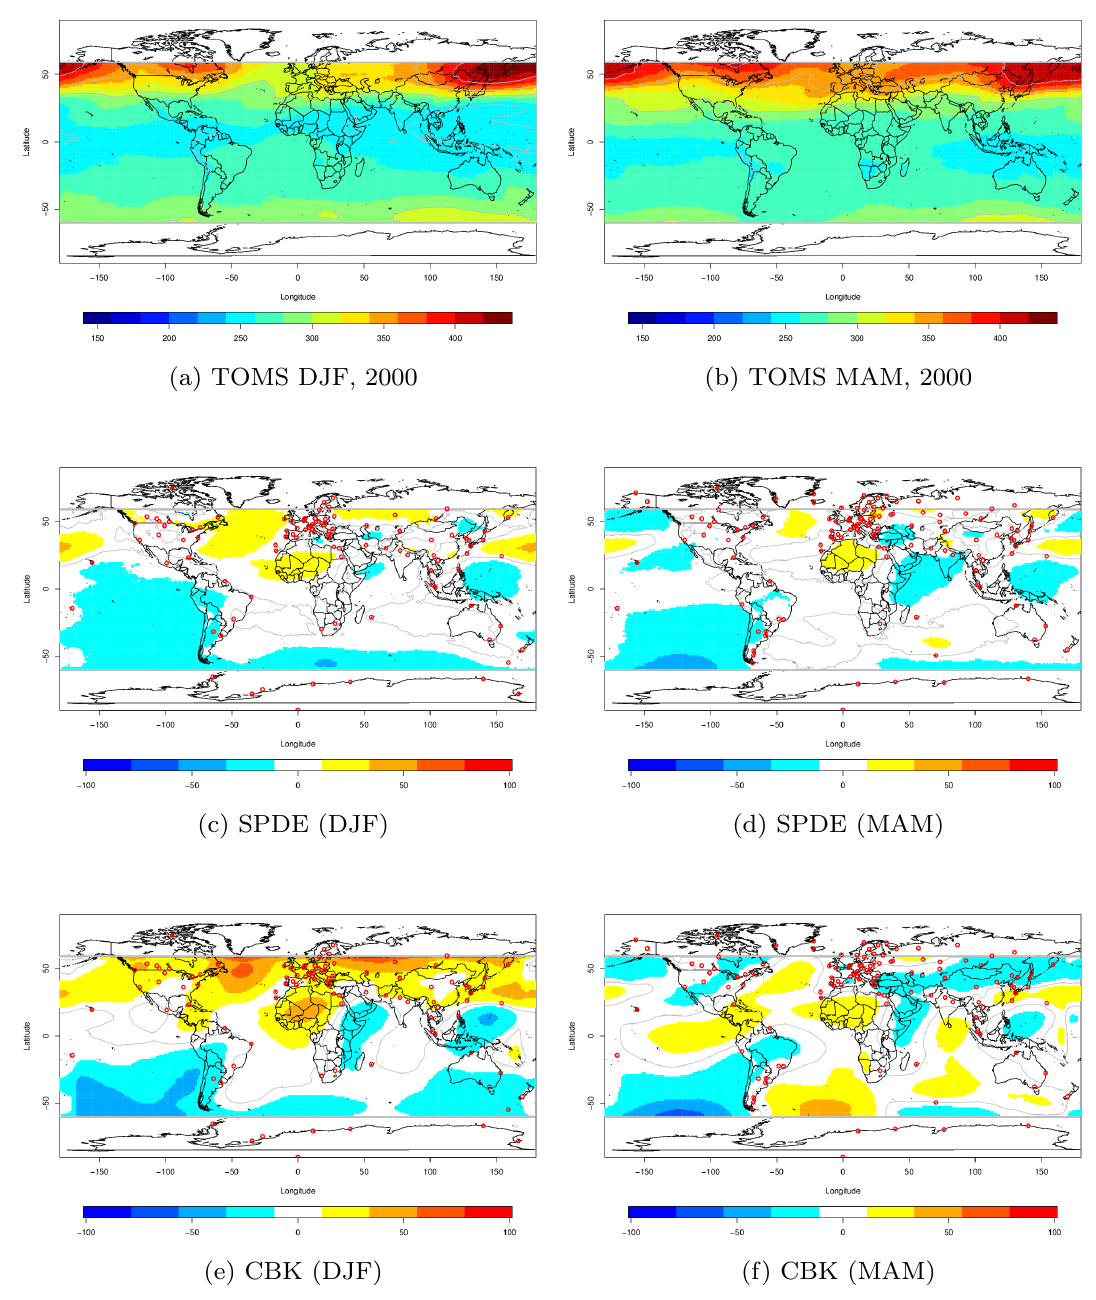
Figure 6. Ozone mapping from TOMS data in (a) DJF and (b) MAM; global difference mapping of SPDE and covariance-based kriging (CBK) predicted mean with respect to TOMS data in DJF ( c and e ) and MAM ( d and f )